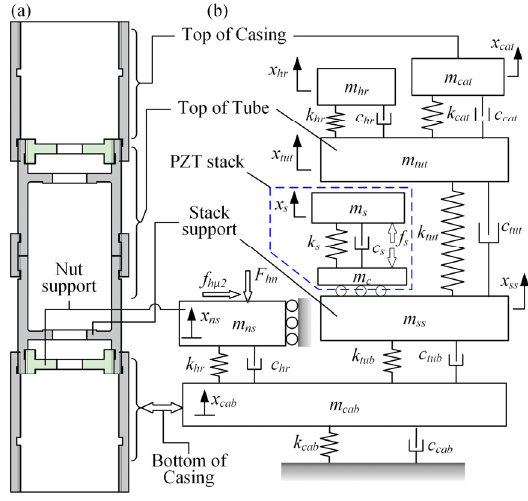
Figure 9. Actuator housing model. ( a ) CAD model; ( b ) equivalent model.